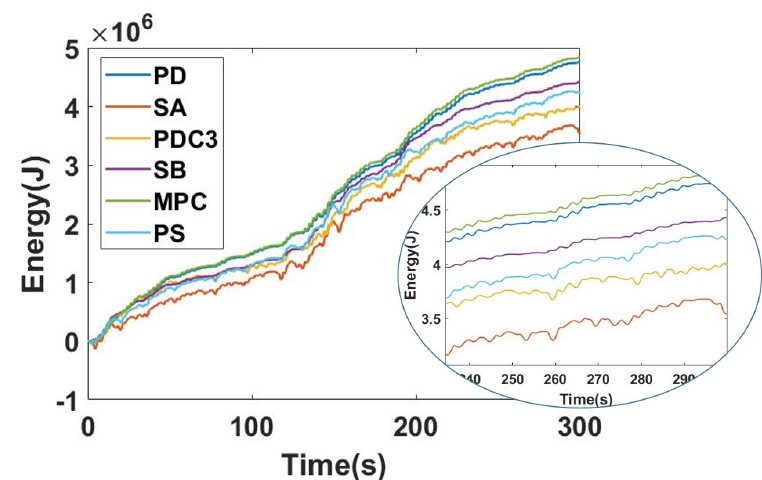
Figure 5. When accounting for displacement constraints, some unconstrained methods harvest less energy. PD: proportional-derivative; SA: singular arc; PDC3: proportional-derivative complex conjugate control; SB: shape-based; MPC: model predictive control; PS: pseudo-spectral.